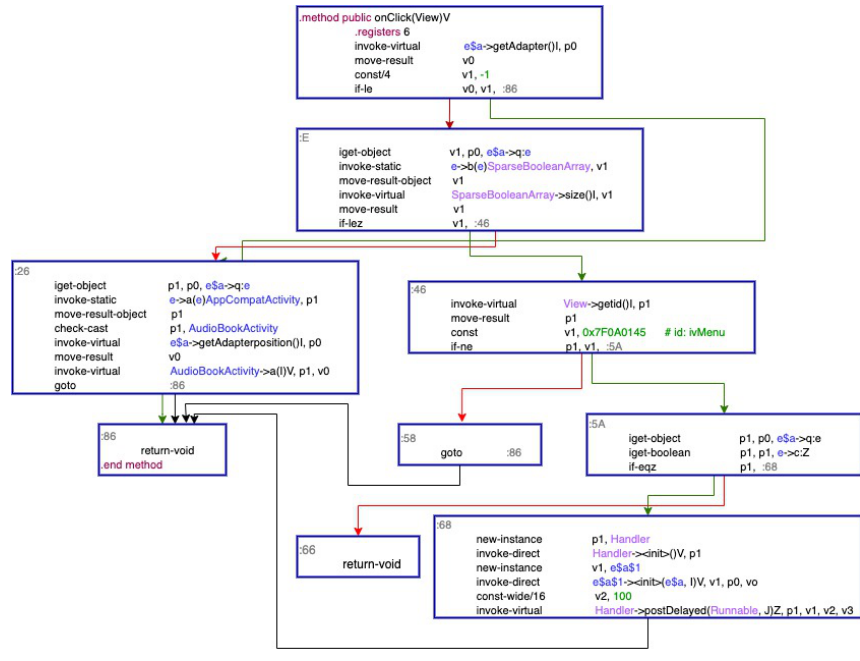
Figure 2. Basic blocks and the relationship among them.